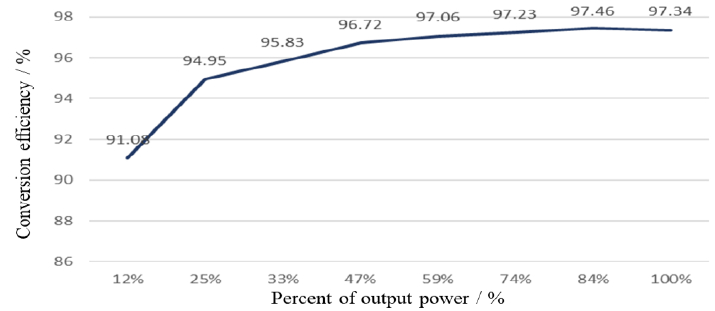
Figure 18. Efficiency curve of the power module.